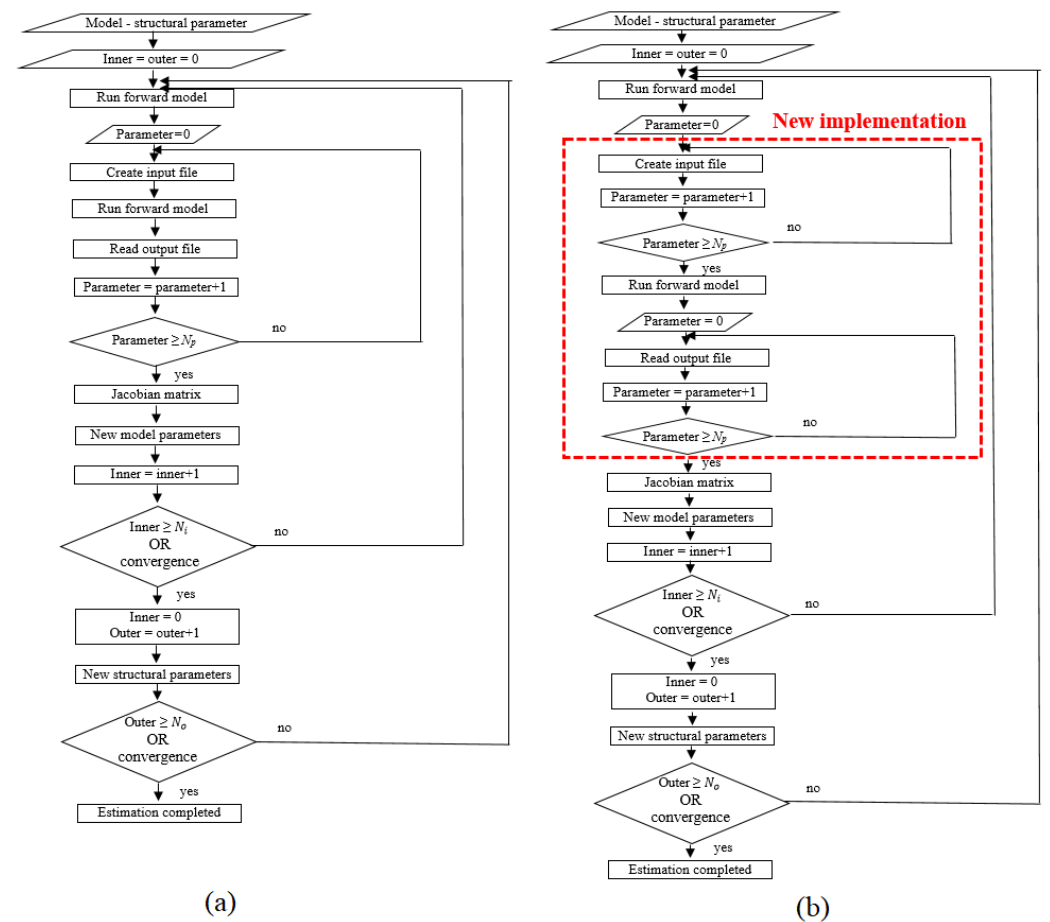
Figure 3. Illustration of BGA algorithm in the serial (a) and parallel (b)